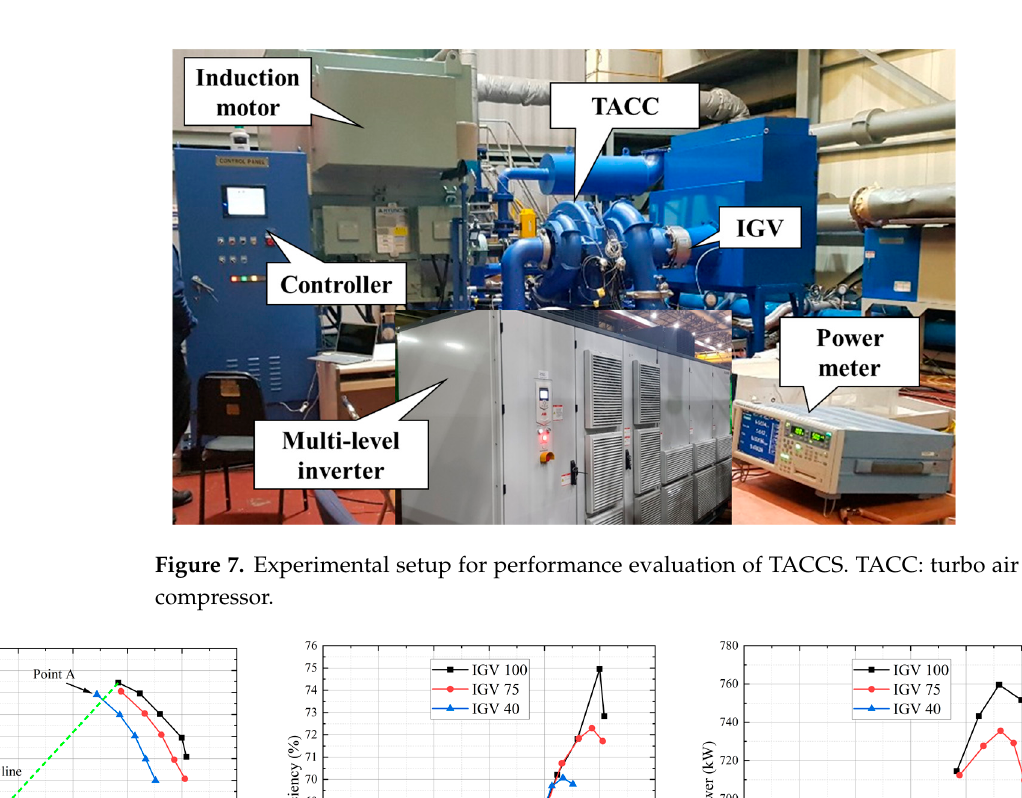
( d ) Figure 6. Performance curves measured at the input terminals of multi-level inverter according to linear and quadratic V/f controls. ( a ) Line to line voltages curves; ( b ) phase current curves; ( c ) power curves; ( d ) efficiency curves of EMDS. The equations using trend line analysis of the power curves according to the linear and quadratic V/f controls can be expressed as follows: Y = − 0.000002x 4 + 0.0011x 3 − 0.052x 2 + 1.9611x + 4.4686 (9) Y = 0.0000002x 4 + 0.0005x 3 − 0.0004x 2 + 0.2887x + 1.6396